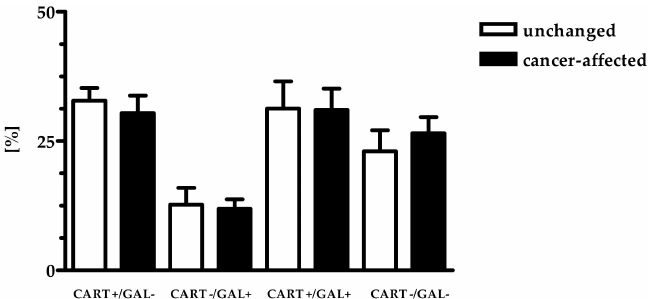
Figure 1. Relative frequency of particular subclasses of neurons presented as percentage (mean ± SD).